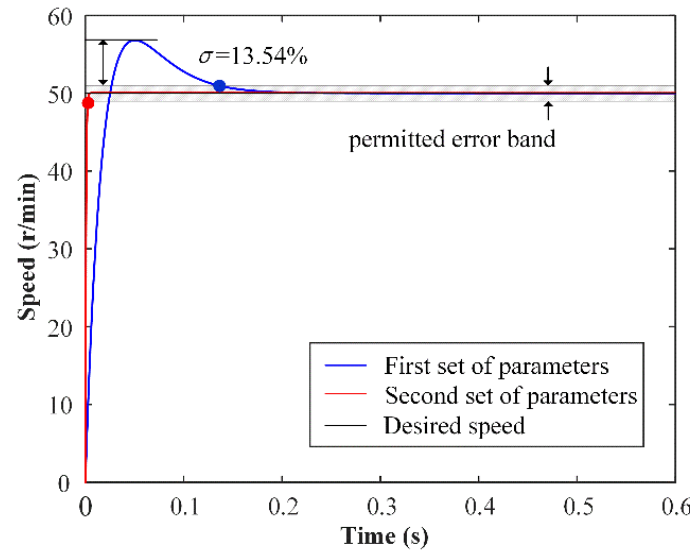
Figure 5. Nominal model step response for different parameters.